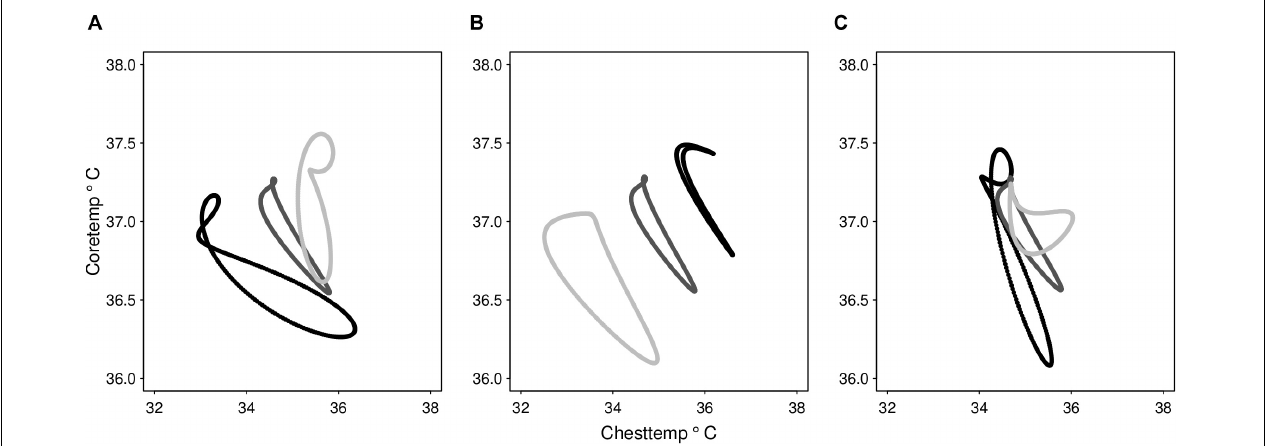
FIGURE 4 | Illustrative examples of the main principal components reconstructions of the dynamics of Chesttemp and Coretemp circadian cycles. Reconstruction of the 24-h loop linking Chesttemp and Coretemp data based on single principal components (PC). For each PC, three subjects in ST2 were selected with corresponding PC values ranged from the highest (black), the median (dark grey), to the lowest (light grey). Reconstruction based on panel (A) PC1 that contains 27.2% of the variability (var.) of cosinor parameter set Y , (B) PC2 that contains 22.4% var., and (C) PC3 that contains 12.9 % var.